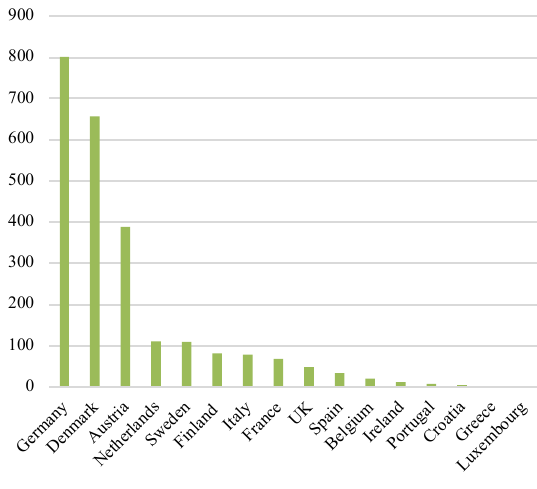
Fig. 4. CE distribution in EU. Adapted from (Bauwens, Gotchev, and Holstenkamp